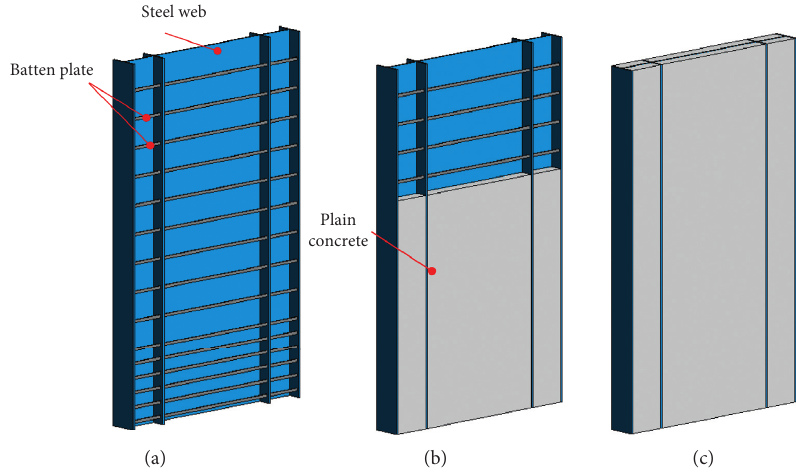
Figure 2: PEC wall system. (a) Steel component. (b) Concrete component. (c) PEC